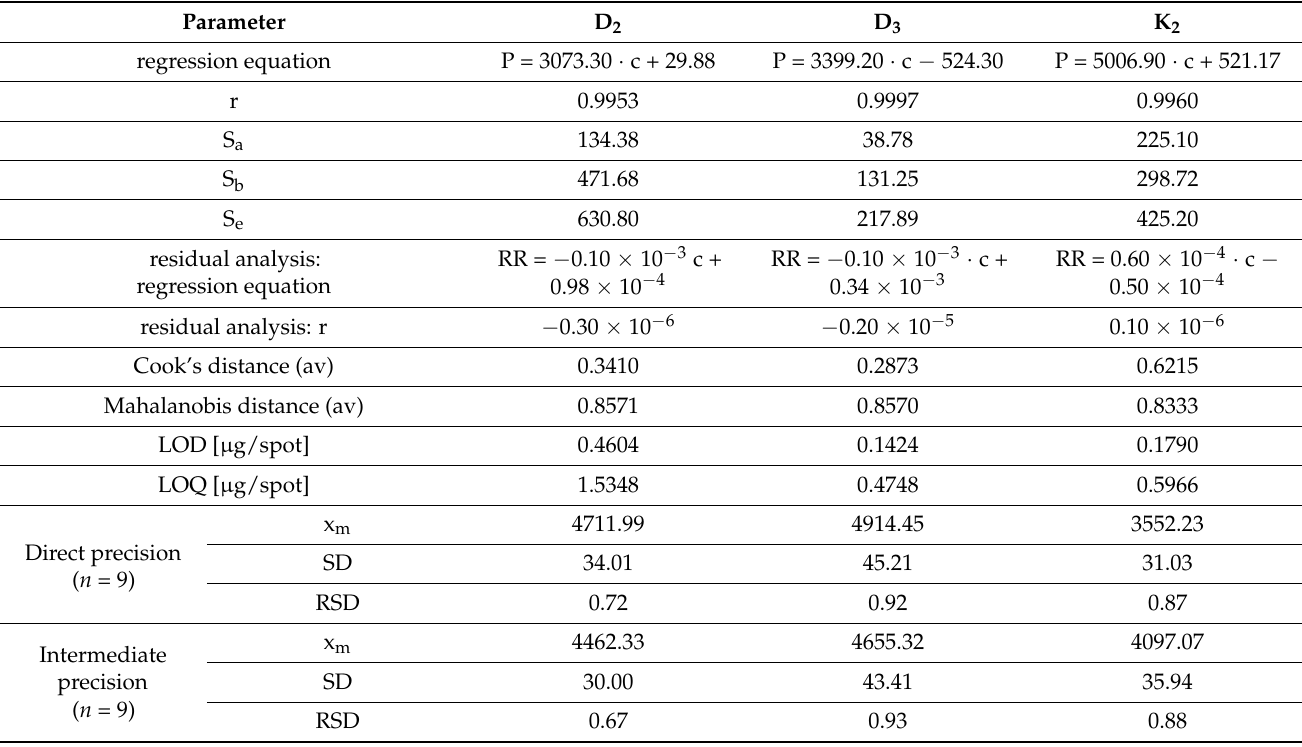
Table 1. Method validation parameters with statistical evaluation specified for vitamin D 2 , D 3 and K 2